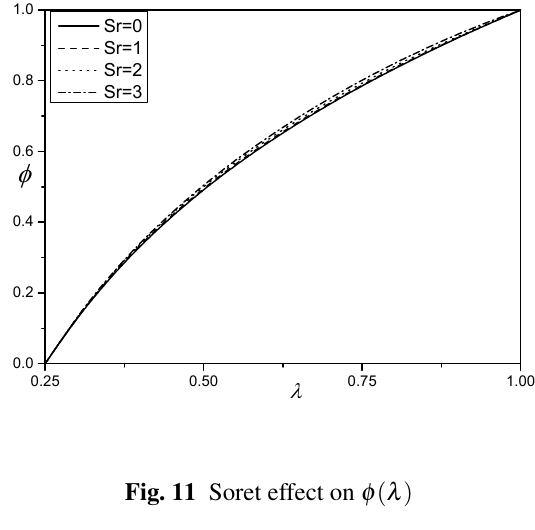
Fig. 11 Soret effect on φ ( λ )